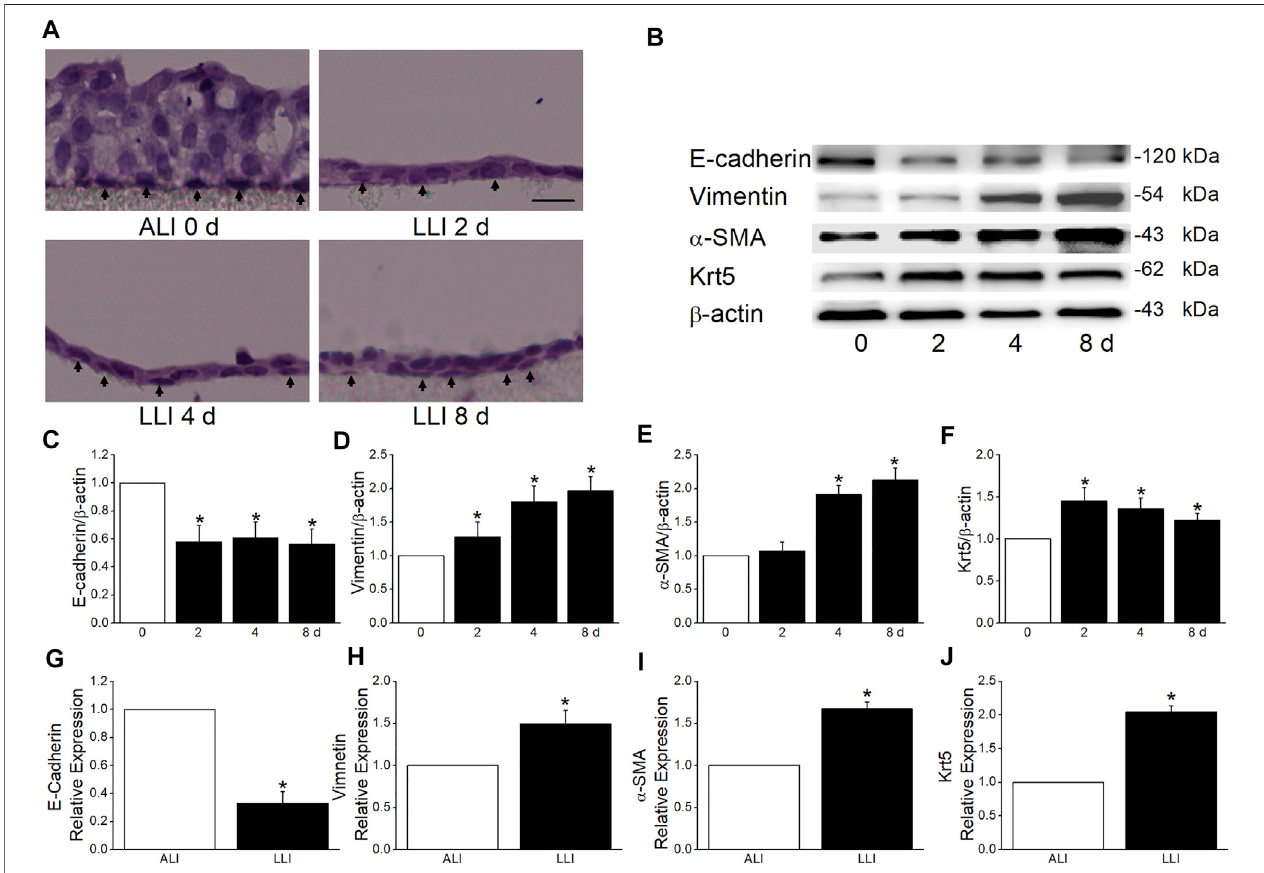
FIGURE2| MTECsunderwentEMTinthemodeofLLIculture. (A) HEstainingofMTECsafter0,2,4,and8 days ’ (d)LLIculturewiththearrowheadsindicatingthe representativecellsineachpanel.Scalebar (cid:1) 10 μ m. (B) RepresentativegraphofEMTmarkers(E-cadherin,Vimentin,and α -SMA)andKrt5after0,2,4,and8 days ’ LLI culture. (C – F) Thestatistical dataofEMTmarkersandKrt5 inthemode ofLLIculture. * p < .05,compared withALIgroup(0 days), n (cid:1) 4. (G – J) Real-time PCRresultsfor EMTmarkerandKrt5mRNAs,and β -actinwasusedasinternalreference.* p < .05,comparedwithALI(0 days), n (cid:1) 4 – 5.Mann – WhitneyUtestwasusedtoanalyze the difference of the means for signi fi